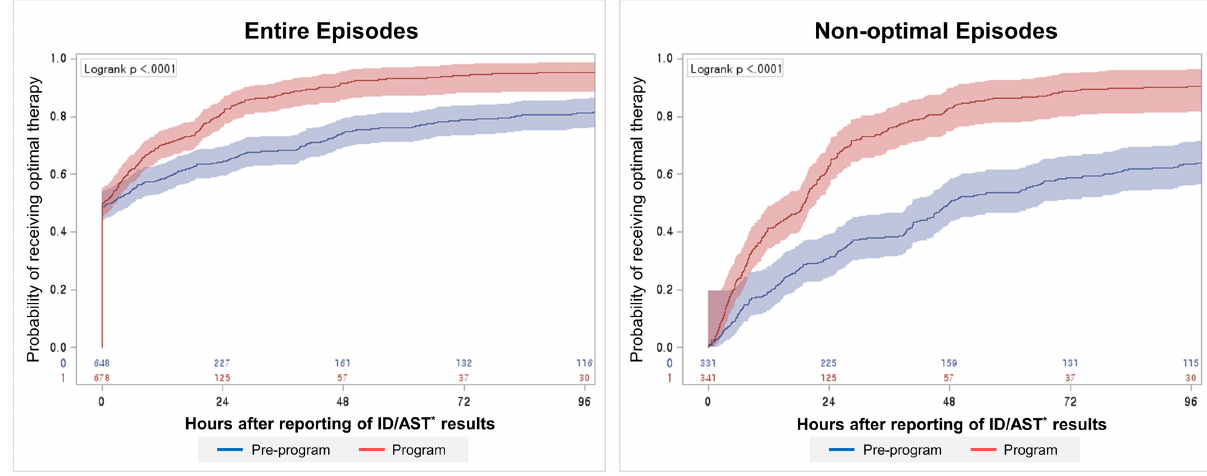
Fig 3. Kaplan-Meier curve of the time to optimal therapy. * Identification and Antimicrobial susceptibility test.